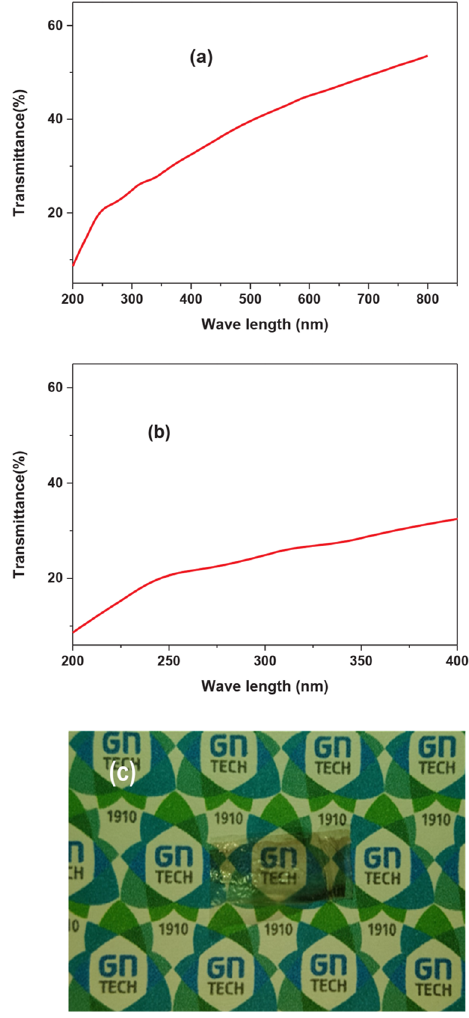
Figure 4. ( a ) UV–Vis spectra of the flexible transparent freestanding GLS-GRP-PVA-150 film, ( b ) the UV spectra region of flexible transparent freestanding GLSGRP-PVA-150 film, and ( c ) digital photo of the flexible transparent freestanding GLS-GRP-PVA-150 film reflecting the transparency. Reproduced with permission [29]. Copyright 2021, Elsevier.